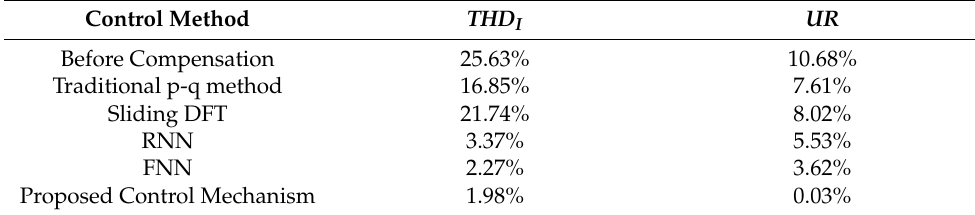
Figure 21. Experimental result of the proposed control mechanism for case 3. Table 4. Experimental results for case